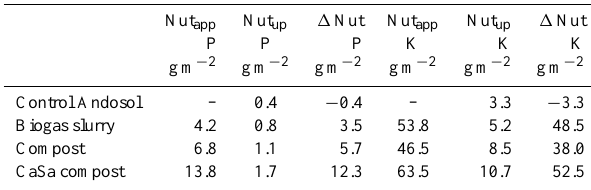
Table 7. Changes in the soil nutrient status ( (cid:49) Nut) along with nu- trients applied by the treatment (Nut app ) and the nutrients taken up by the crop (Nut up